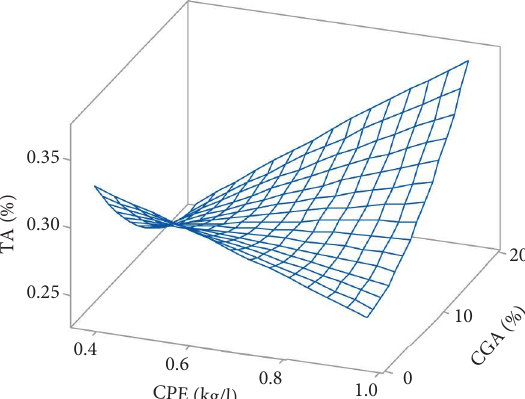
Figure 7: Response surface for titrable acidity of tomatoes as function of pineapple peel extract concentration and Arabic gum concentration.